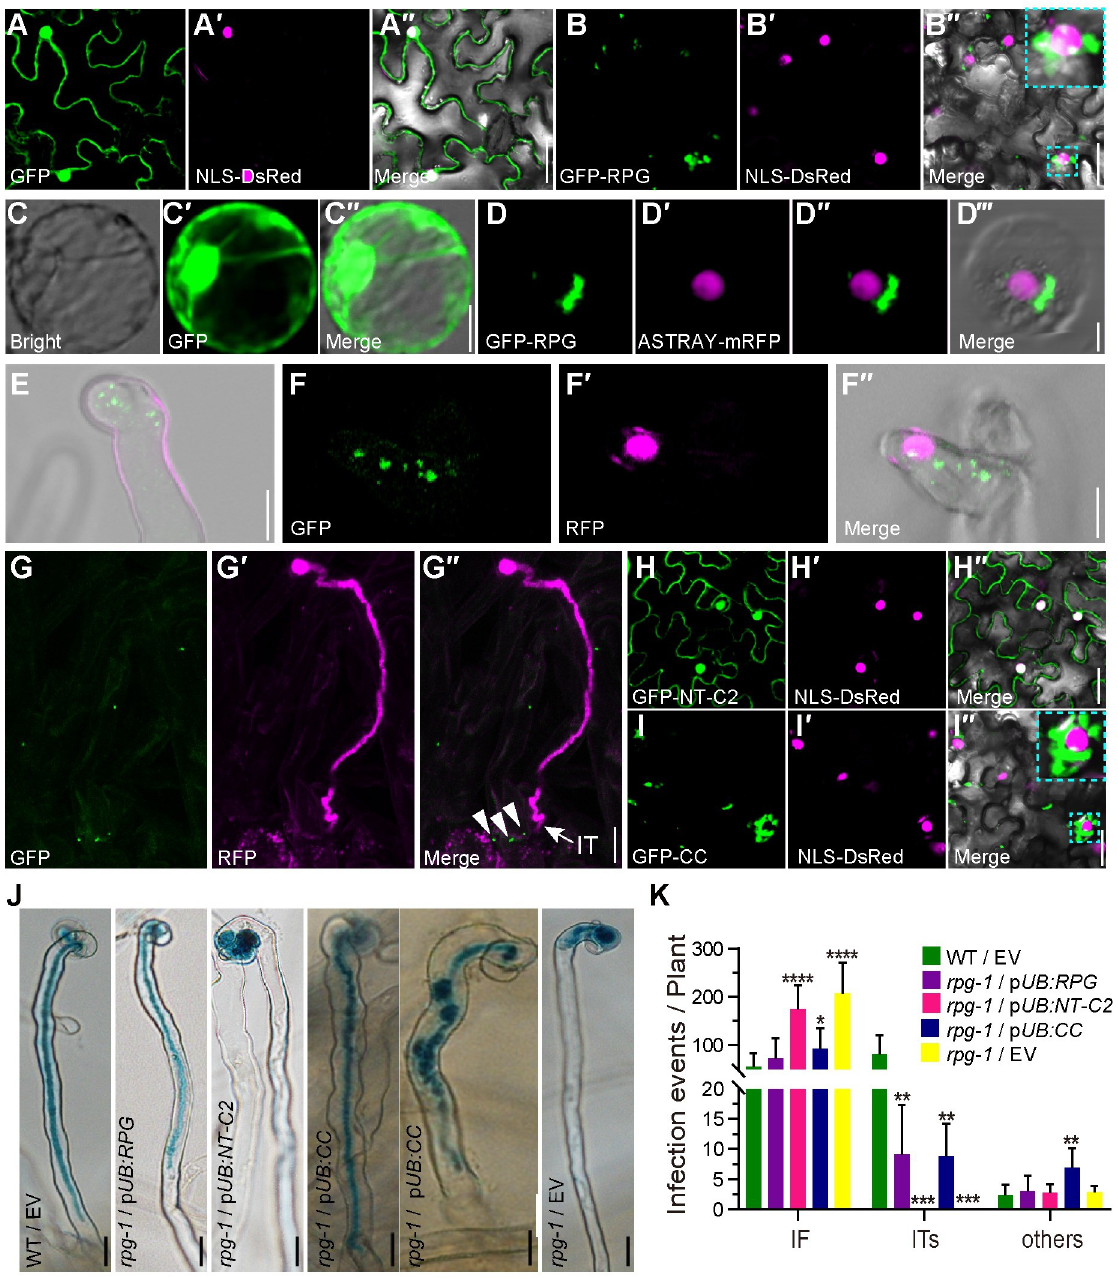
Fig 4. Subcellular localization of the RPG protein in N . benthamiana leaves and L . japonicus roots. (A, B, H and I) Confocal microscopy images of N . benthamiana leaves expressing p 35S : GFP (A), p 35S : GFP-RPG (B), and the separate RPG domains p 35S : GFP-NT-C2 (H) and p 35S : GFP-CC (I). In each, the green, magenta and merged images are shown in adjacent panels. The nucleus was labeled with NLS-DsRed (magenta). Sections within an image that are outlined in dotted Cyan lines are showed enlarged in the top right corner of that image. (C -D) p 35S : GFP (C) or p 35S : GFP-RPG (green) and the nuclear marker, ASTRAY5-mRFP (magenta) (D), were co-expressed in L . japonicus root protoplasts using a DNA-PEG-calcium transfection method. (E to G) p RPG : GFP-RPG was introduced into rpg-1 by A . tumefaciens - mediated stable transformation. RPG subcellular localization were analyzed using whole-mount immunolocalization with anti-GFP primary antibody and Alexa Fluor 488-conjugated Affinipure donkey anti-Mouse IgG secondary antibody, 5 or 10 days after inoculation with M . loti MAFF303099/RFP. Green shows RPG subcellular localization and magenta shows M . loti . Close arrowheads indicate RPG subcellular localization and arrow indicate IT (G). (J-K) Assays of complementation of the rpg-1 mutant by the predicted NT-C2 domain (p UB : NT-C2 ) and by RPG lacking the NT-C2 domain (p UB : CC ) showing the NT-C2 domain is not required for complementation of infection. Infection phenotypes (J) and Infection events (K) of the p UB : NT-C2 or p UB : CC were expressed in rpg-1 , and the phenotypes were scored after